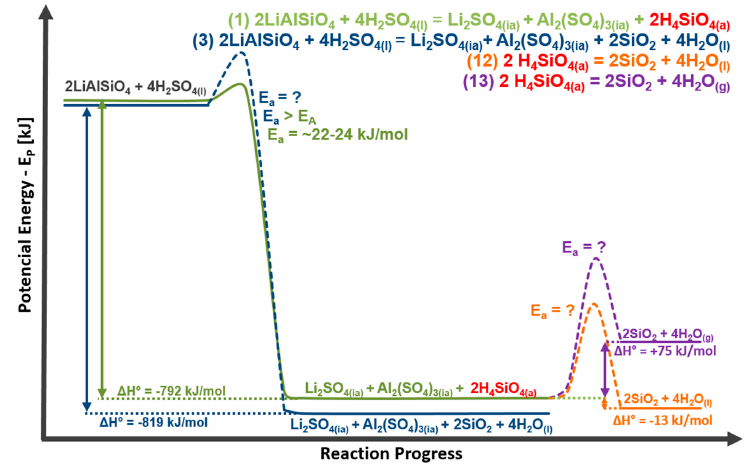
Figure 15. Potential energy diagram of LiAlSiO 4 phase leaching with the focus on the silicon phases. Thermodynamic analysis shows, that reaction (3) is thermodynamically favorable, but high Si concentration in the solution confirms that the leaching takes place according to reaction (1). After leaching, it was not possible to observe a decrease in the concentration of silicon in the solution, from which it can be concluded that reactions (12) and (13) do not proceed despite the fact that their Δ G° values are negative. One of the possible reasons why SiO 2 does not precipitate out from solutions may be the fact, that E a of reactions (3), (12) and (13) were not reached. Specific values of these activation energies cannot be determined experimentally due to the fact that these reactions do not take place during direct leaching. Therefore, these values are marked in Figure 15 as unknown with dashed lines. Part of the energy generated by the exothermic direct leaching, according to reaction (1), could be sufficient to overcome the activation energy of reaction (12) or even (13), but this direct